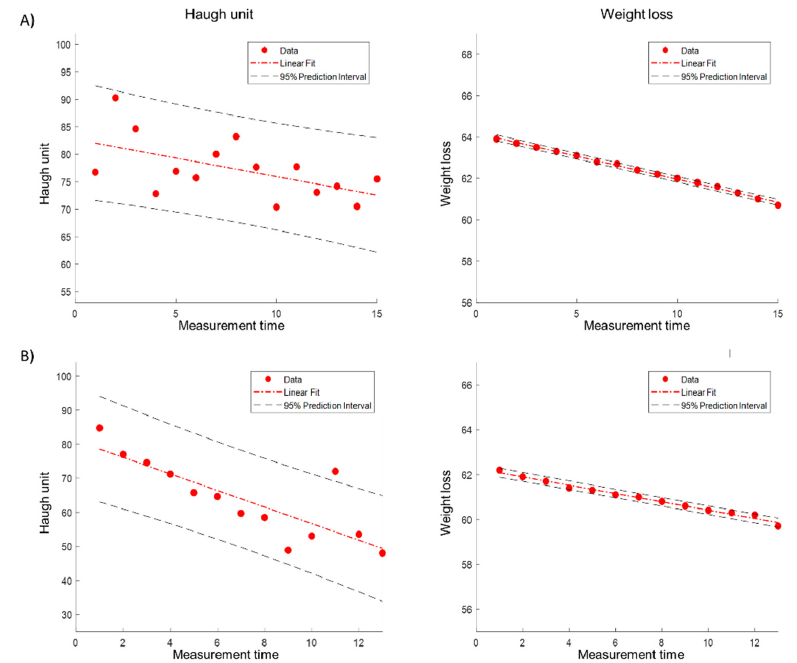
Figure 5. Calculated HU and weight loss of egg for dynamic and real-time cold chain temperature